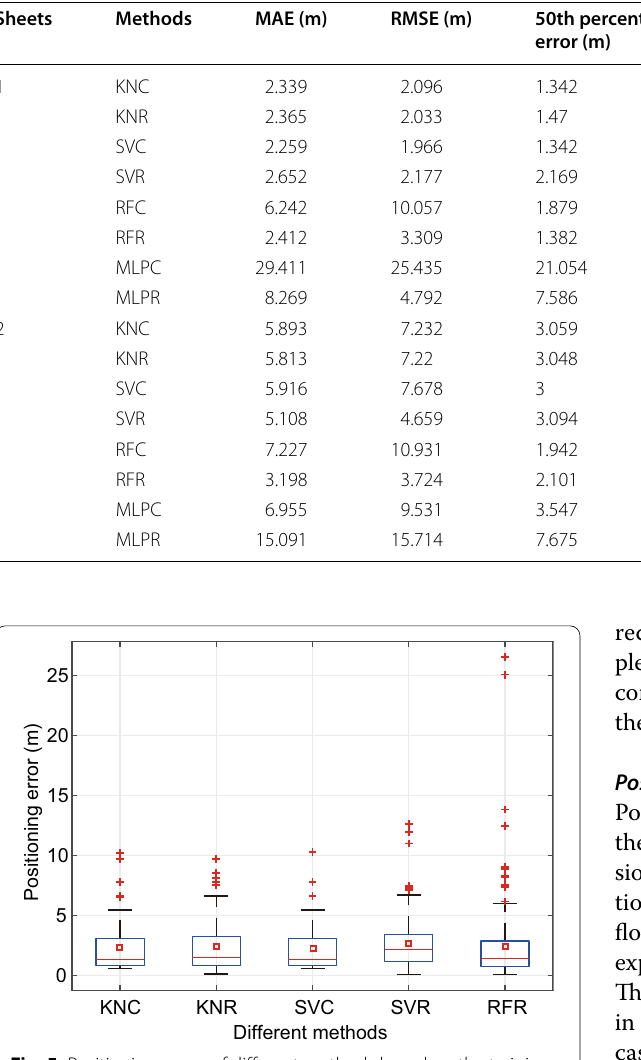
Fig. 5 Positioning errors of different methods based on the training sheet containing all APs and thirty samples at each RP in the HCXY